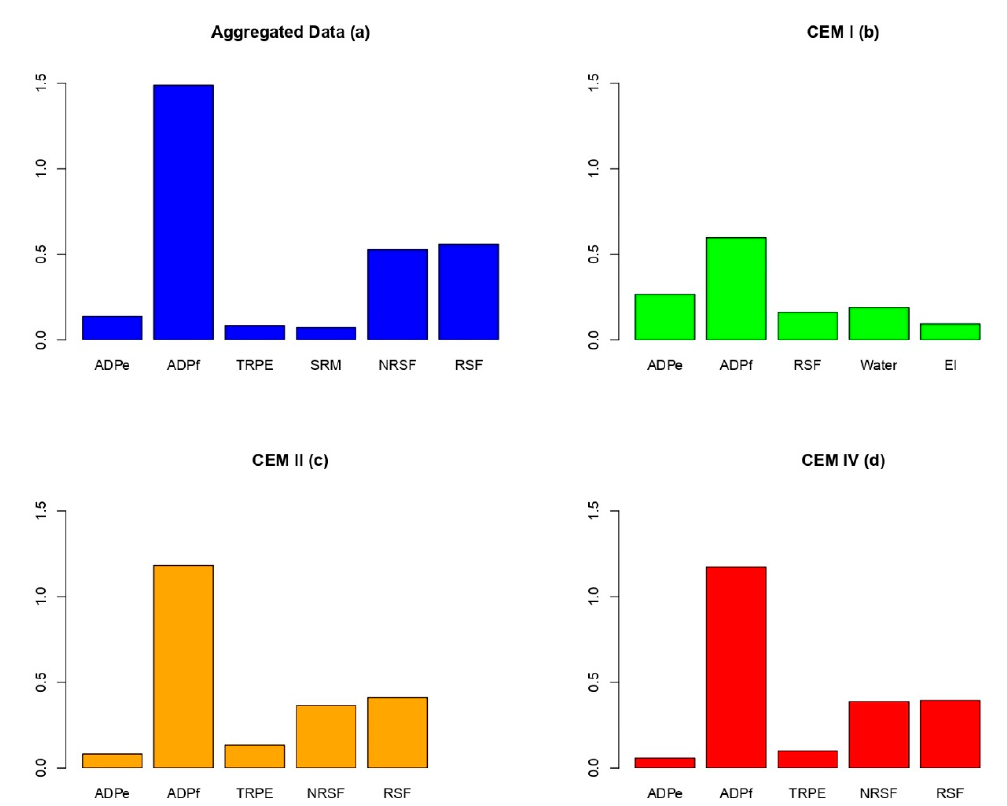
Figure 7. Size of the coefficients (AIC selected components) for each type of cement (absolute values). ( a ) aggregated data; ( b ) CEM I; ( c ) CEM II; ( d ) CEM IV.